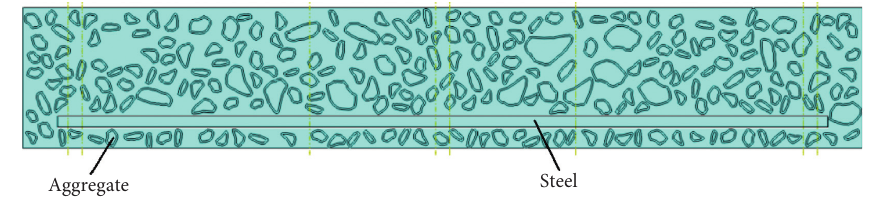
Figure 2: Aggregate placement.